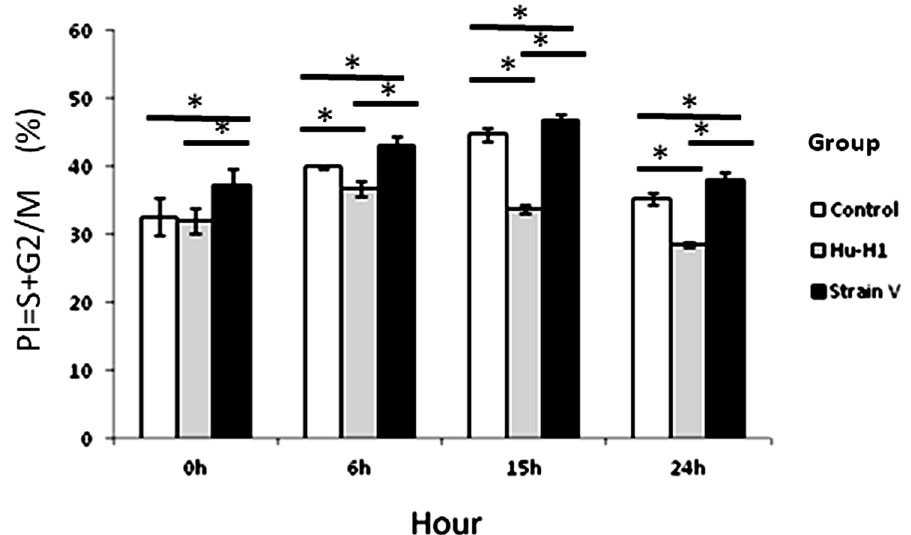
Figure 4. Proliferation indexes in Hu-H1, Strain V, and control cells. * p , 0.05.